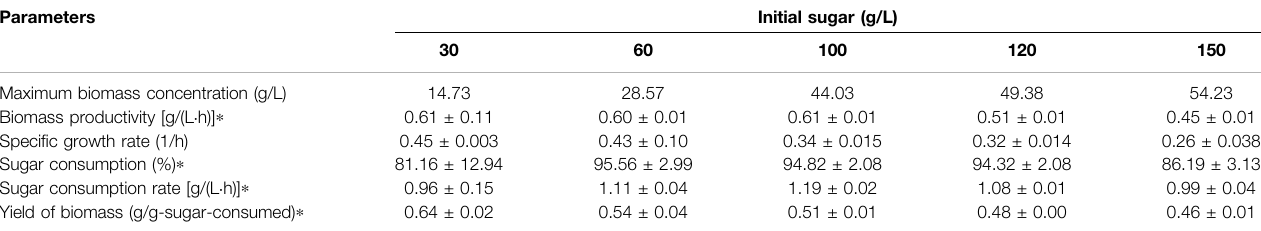
TABLE 3 | Kinetic parameters of Paracoccus sp. KKU01 grown on sugarcane juice-based medium at initial total sugar concentrations of 30 – 150 g/L.